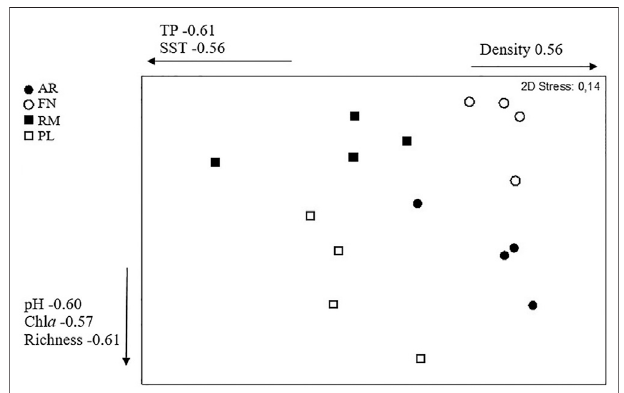
FIGURE 4 | Non-metric multidimensional scaling (nMDS) ordination of a Bray – Curtis similarity matrix ofmacroinvertebrate composition. Sampling river (circlesAR, Arroyito; FN, Fortín Nogueira) and reservoir (squares RM, Ezequiel Ramos Mexía; PL, Pichi Picún Leufú) sites of Limay River, Patagonia, Argentina. White panels represent the not invaded sites and black panels the invaded sites. The variables that were signi fi cantly correlated with the nMDS axes are